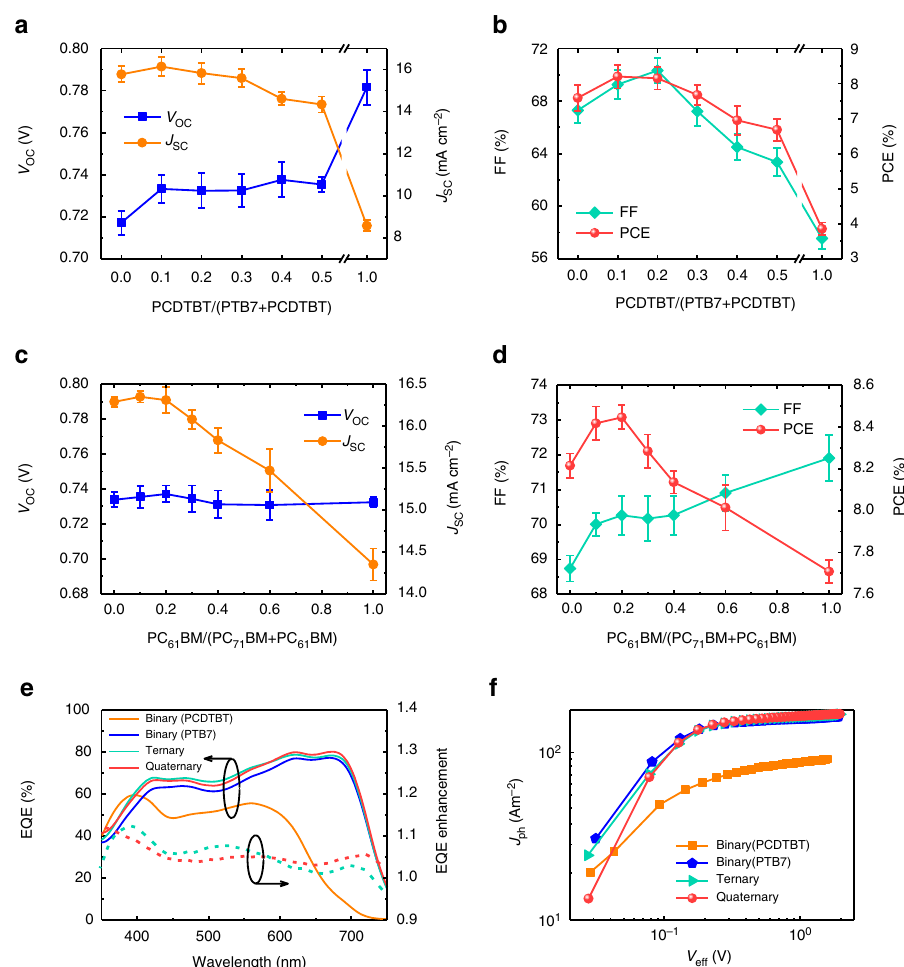
Figure 2 | Optimization of compositions of the donors and acceptors in the q-OPV. Photovoltaic parameters as a function of PCDTBT concentration ( x , 0 r x r 1) in PTB7:PCDTBT:PC 71 BM (1 (cid:2) x : x :1.5) blends ( a , b ) and PC 61 BM concentration ( y , 0 r y r 1.5) in PTB7:PCDTBT:PC 71 BM:PC 61 BM (0.9:0.1:1.5 (cid:2) y : y ) blends ( c , d ). The average and s.d. values in figures a – d were calculated using data from more than 16 cells. ( e ) EQE spectra and ( f ) J ph – V eff characteristics of the b-, t- and q-OPVs. The EQE enhancement indicates the ratio of ternary (dotted turquoise line) or quaternary (dotted red line) devices to the PTB7-based binary